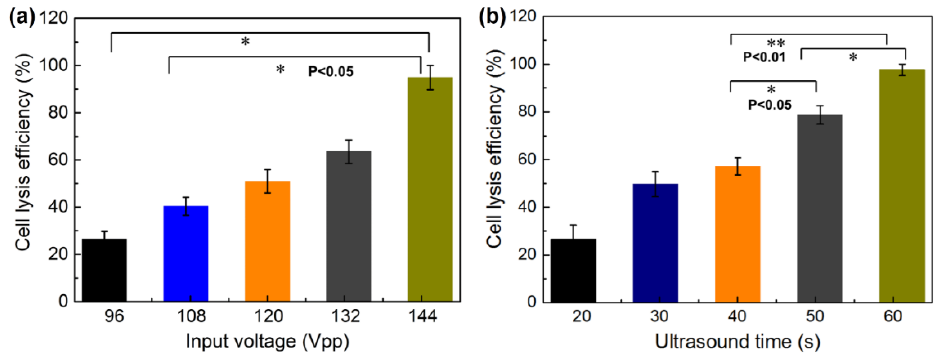
Figure 9. MCF-7 cell lysis e ffi ciency. ( a ) Lysis e ffi ciency of MCF-7 cells for di ff erent input voltages Figure 9 . MCF-7 cell lysis efficiency. ( a ) Lysis efficiency of MCF-7 cells for different input voltages of of 96, 108, 120,132, and 144 Vpp and the lysis time is 3 min. The cell lysis e ffi ciency increases with 96, 108, 120,132, and 144 Vpp and the lysis time is 3 min. The cell lysis efficiency increases with the the increment of input voltage. ( b ) MCF-7 cell lysis e ffi ciency for ultrasonic times of 20, 30, 40, 50, increment of input voltage. ( b ) MCF-7 cell lysis efficiency for ultrasonic times of 20, 30, 40, 50, and and 60 s when the input voltage is 144 Vpp. The cell lysis e ffi ciency increased with the increment of 60 s when the input voltage is 144 Vpp. The cell lysis efficiency increased with the increment of ultrasonic time. ultrasonic time.